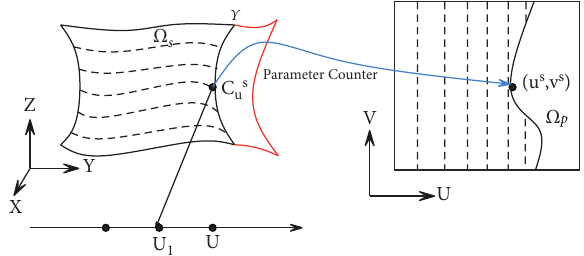
Figure 2: Back-calculation of cutting surface parameters of objects transported in the supply chain.